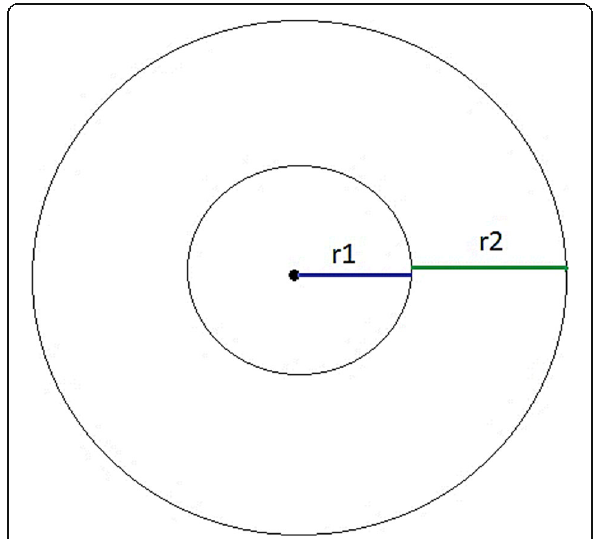
Fig. 1 Schematic description for particle